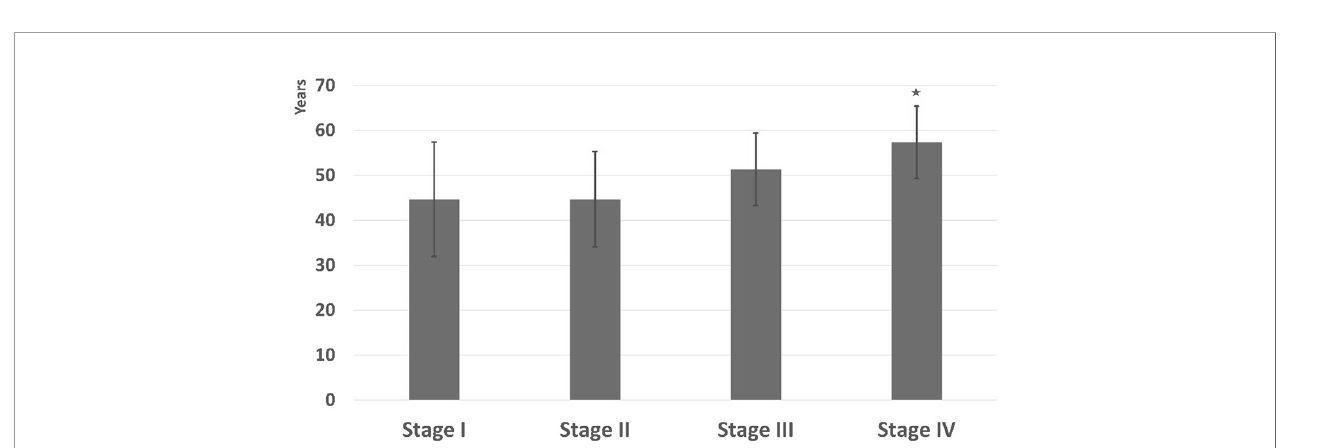
FIGURE 10 | Age of participants in different clinical stages. *Signi fi cant vs . stage